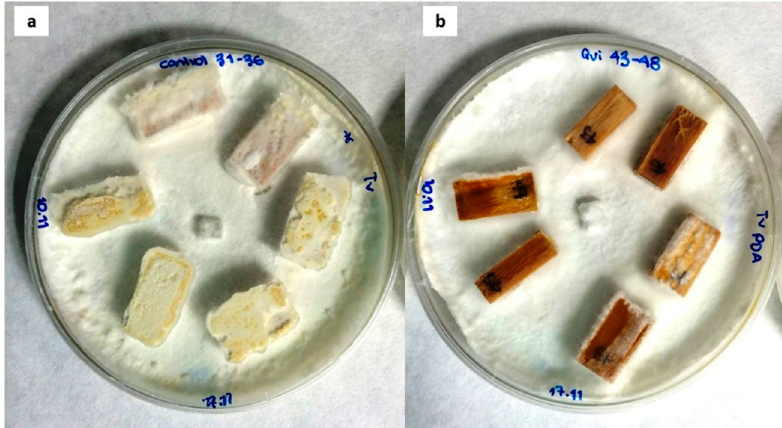
Figure 1. Poplar wood samples 30 days after exposure to T. versicolor : ( a ) control wood sample and ( b ) sample treated with medium molecular weight chitosan .